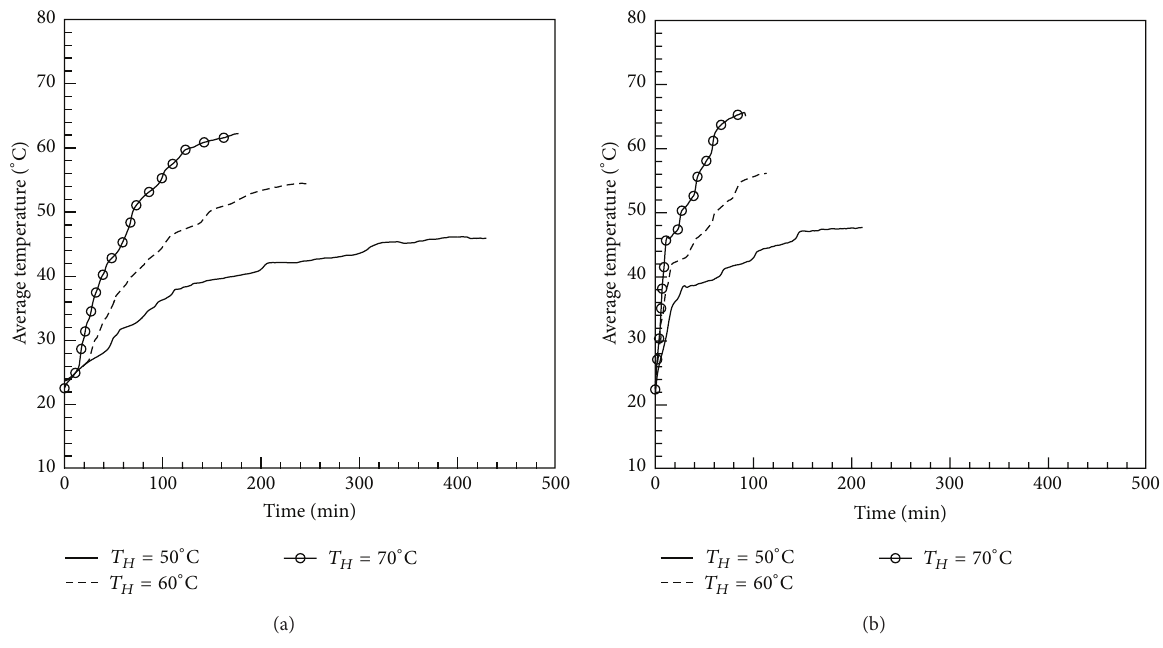
Figure 5: Comparison of average temperature profile in the PCM at various hot inlet HTF temperatures ( 𝑇 𝐻 ) in charging process: (a) bared tube heat exchanger; (b) finned-tube heat